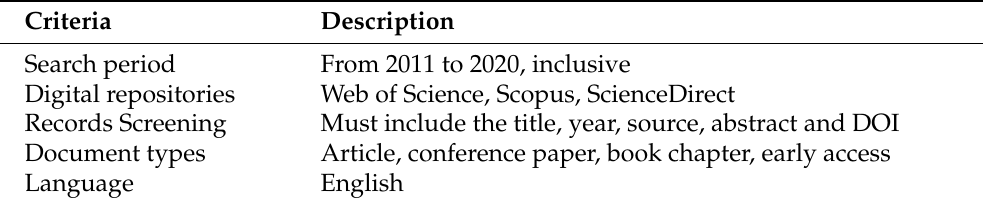
Table 1. Inclusion criteria for the data collection phase of the survey of the emerging trends of Agriculture